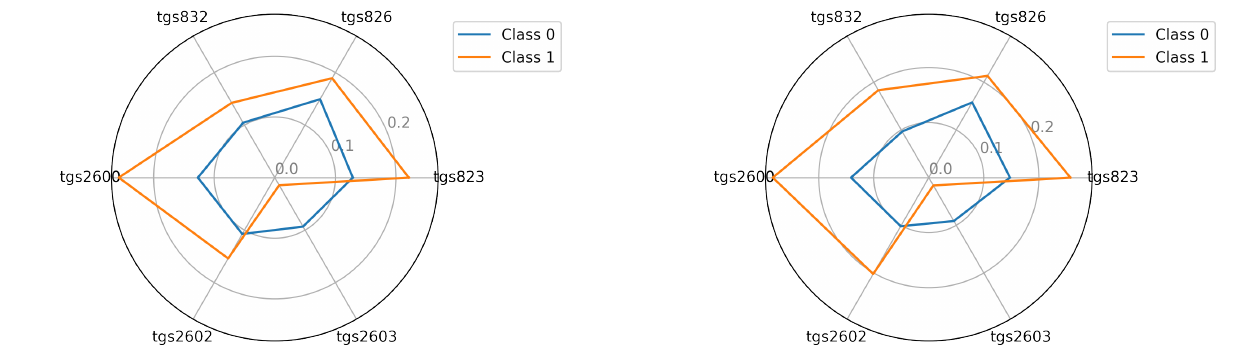
Figure 5. Visualisation for device bee 1: Squared the average reading in classes 0 and 1; bee 1.2 and bee 1.3 ( left ) and ( right ), respectively.